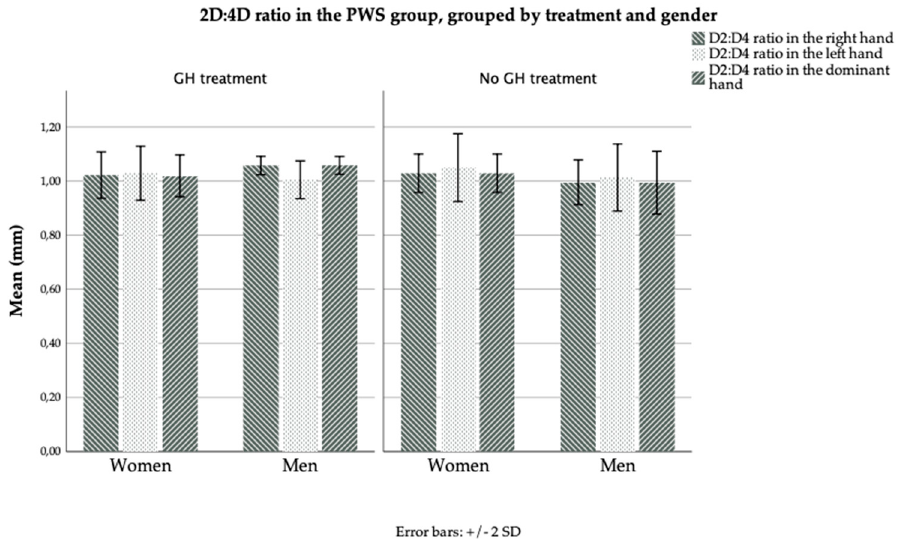
Chart 4. Characteristics of 2D:4D ratios in PWS participants with and without GH treatment during childhood/adolescence, by gender.